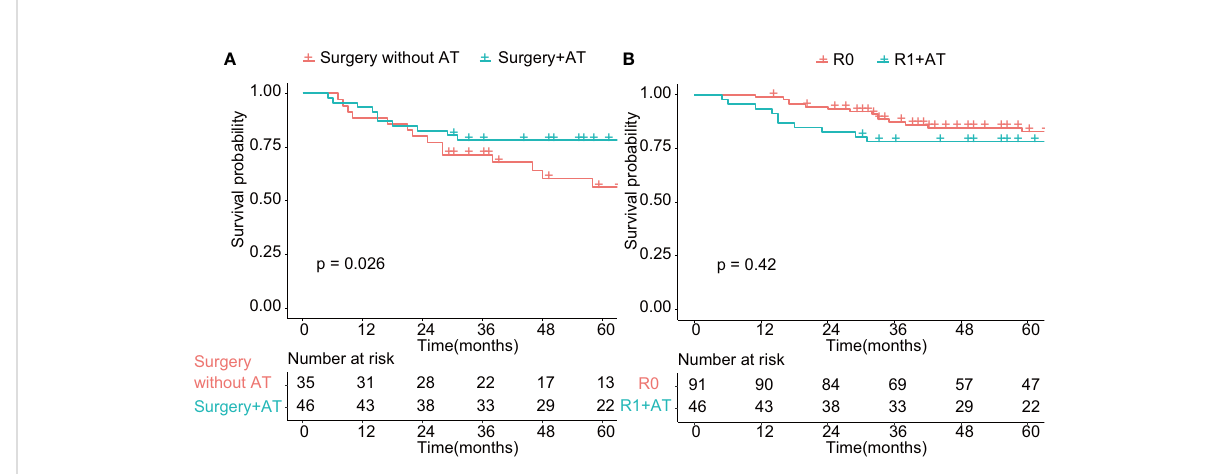
FIGURE 4 Comparison of overall survival in patients treated with adjuvant therapy ( p < 0.05). AT: adjuvant therapy. (A) Comparison of overall survival of patients undergoing surgery with or without adjuvant therapy ( p < 0.01). (B) Comparison of overall survival of patients undergoing R0 resection and patients undergoing R1 resection with adjuvant therapy ( p > 0.05). R0: Microscopically margin-negative resection (R0 resection); R1 + AT: Macroscopic complete resection (R1 resection) with adjuvant